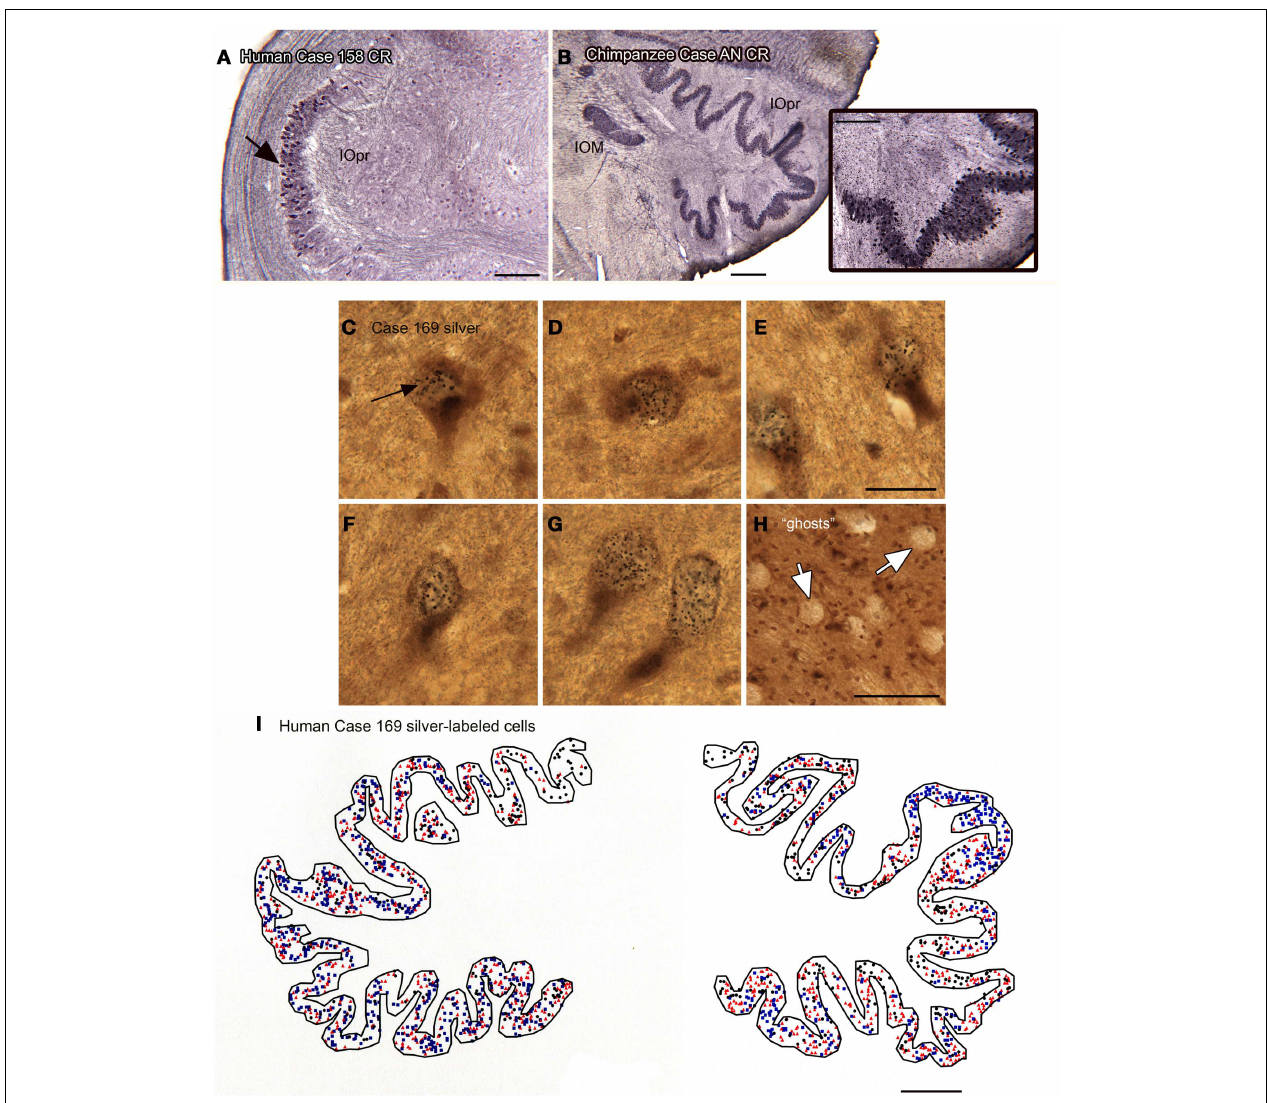
neurons in the IOpr of Case 169 (male, age 70) labeled with black silver grains. Scale bar 20 µ m. (H) The arrows indicate “ghosts,” spaces the size and shape of IOpr neurons. Scale bar 100 µ m. (I) Plot of the distribution of cells marked with silver grains on a section from Case 169.Three different symbols are used to indicate relative numbers of silver grains: black circle, few; red triangle, intermediate; blue square, many. Scale bar